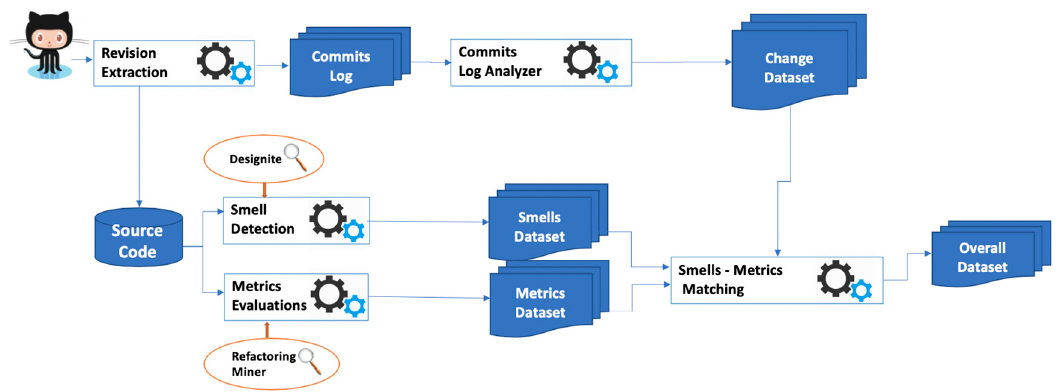
Figure 1. Toolchain used for the gathering the required data.